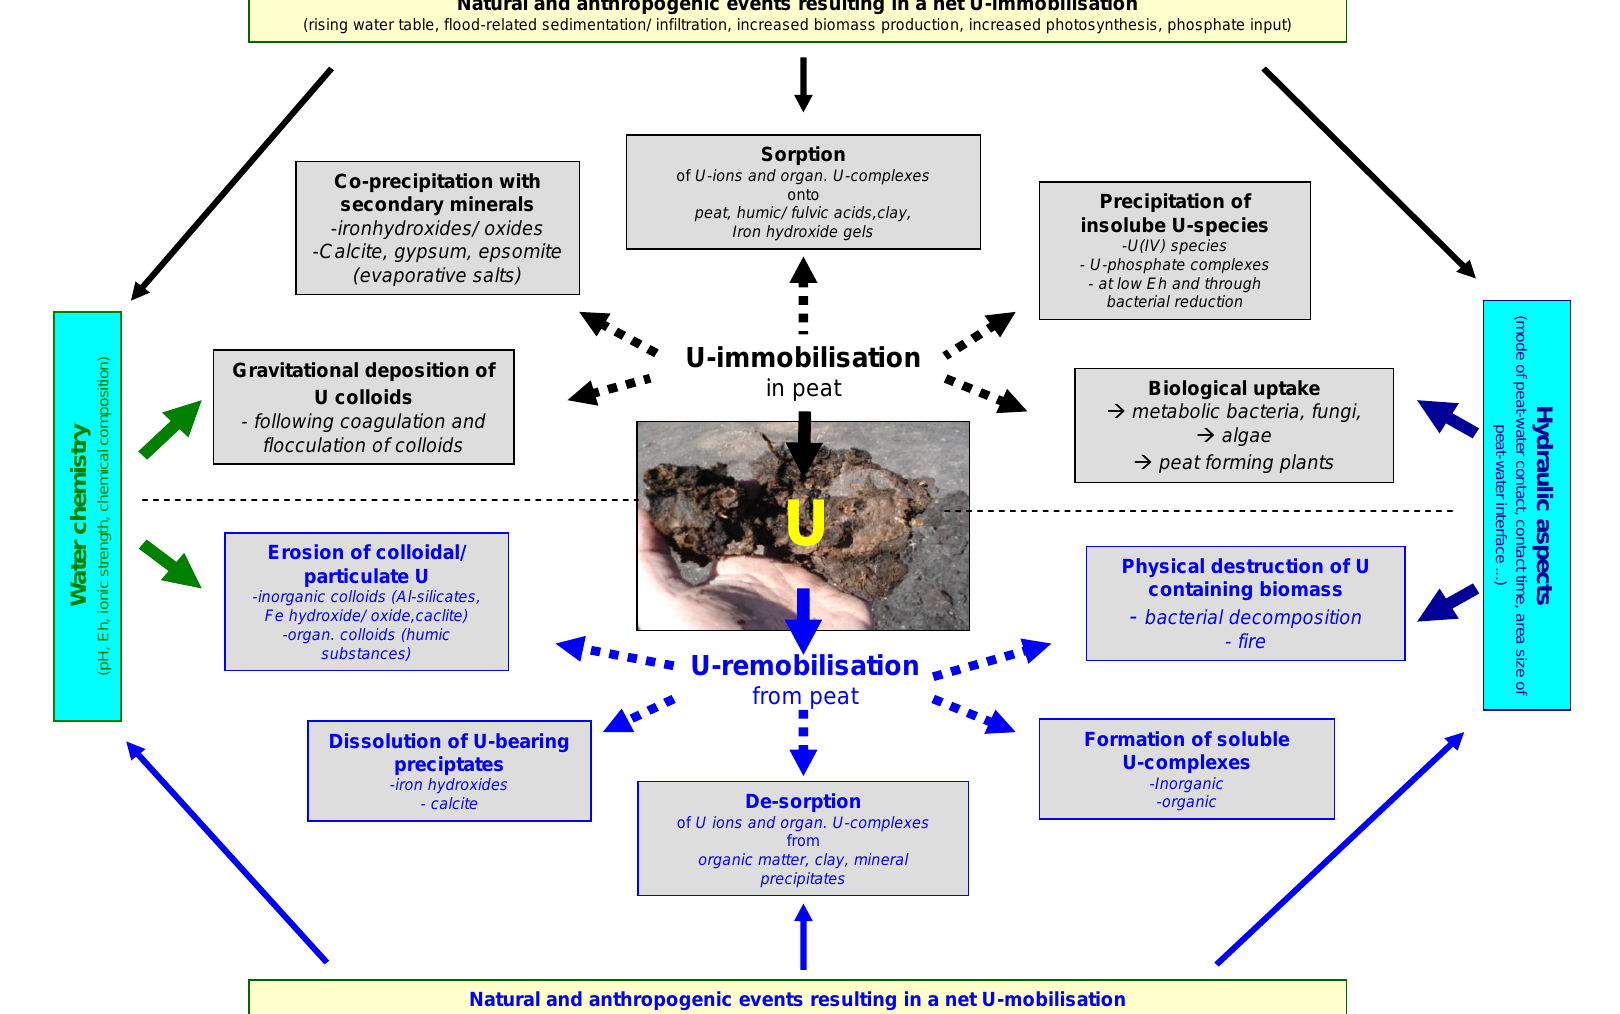
Figure 1. Overview on processes governing the immobilization and remobilization of U in/from peat including controlling factors and triggering events (chemical component of the U filter model for